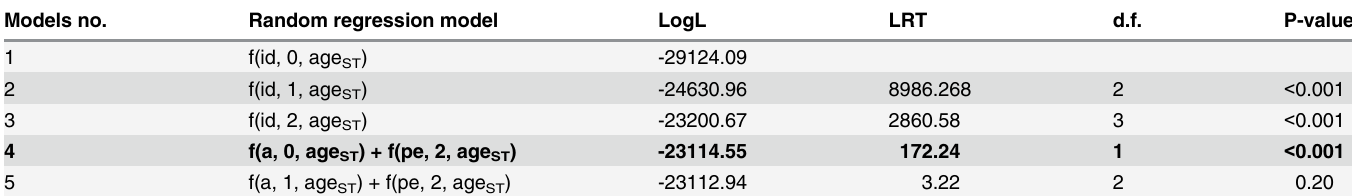
Table 3. Results of the selection strategy of the best random regression animal model for ejaculate size. LogL, the Log Likelihood of the model, LRT the likelihood ratio test, d.f., the degree of freedom defined as the number of random term(s) (variance(s) and covariance(s)) added for fitting each model in comparison of previous model. Note that f(id, 3, age ST ) and f(a, 2, age ST ) + f(pe, 2, age ST ) did not converge. A plot of the best model can be found in Fig 2 (using MCMCglmm estimates) and in S3 Text (using ASReml estimates). Models